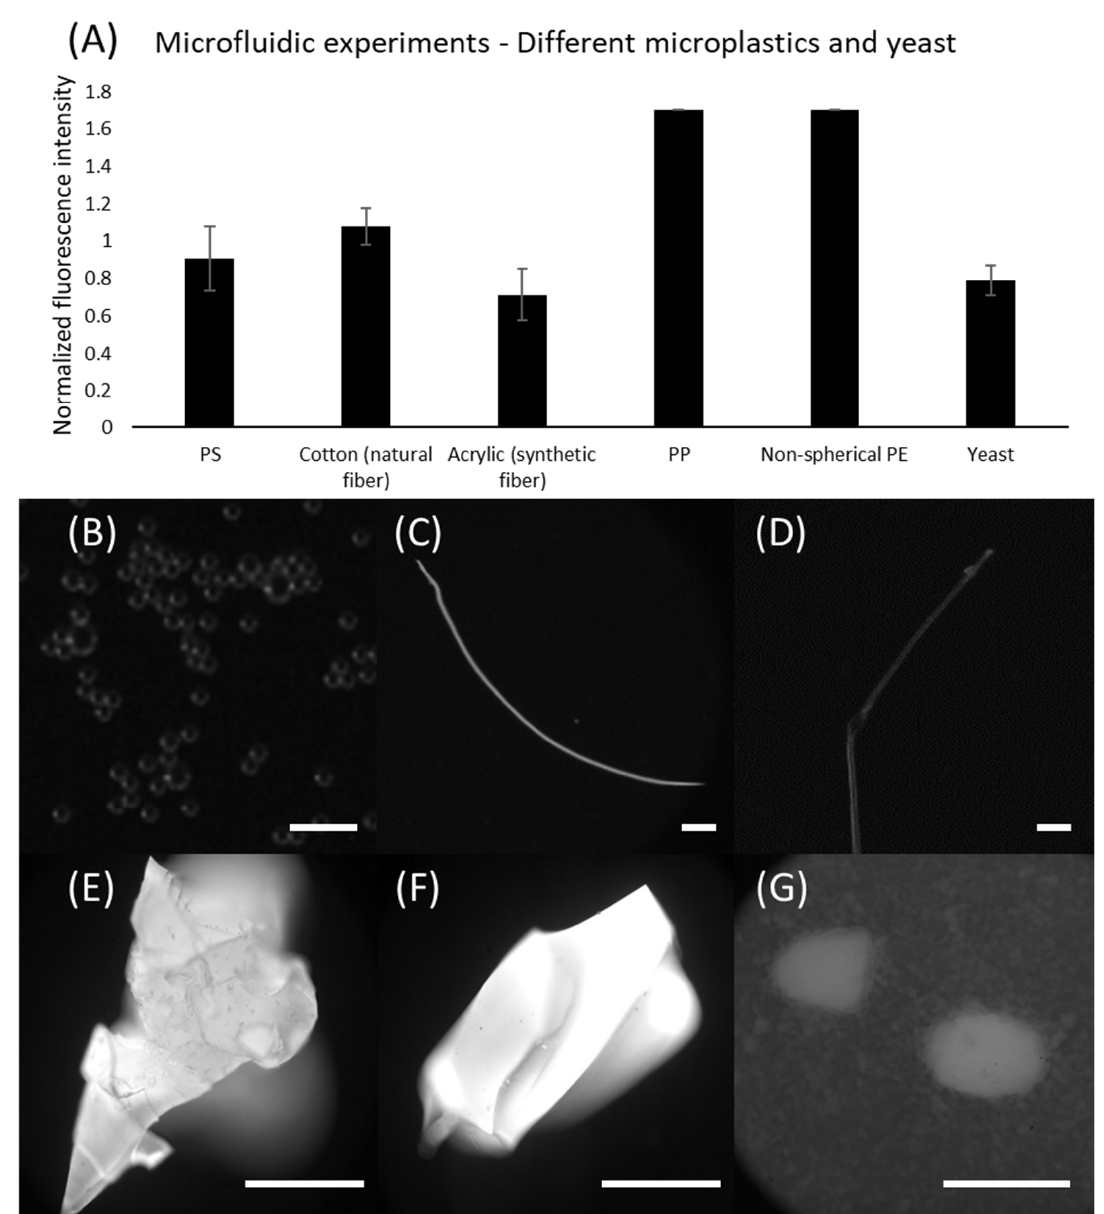
Figure 7. Microfluidic staining for different plastics and yeast. ( A ) Fluorescence levels for different microplastics and yeast; ( B ) PS microspheres; Scale bar is 50 µm; ( C ) Cotton (natural fiber); ( D ) Acrylic (synthetic fiber); Scale bars are 1 mm; ( E ) PP from storage container; Scale bars are 50 µm. ( F ) PE from storage container; Scale bars are 50 µm. ( G ) Yeast; Scale bars are 50 µm.